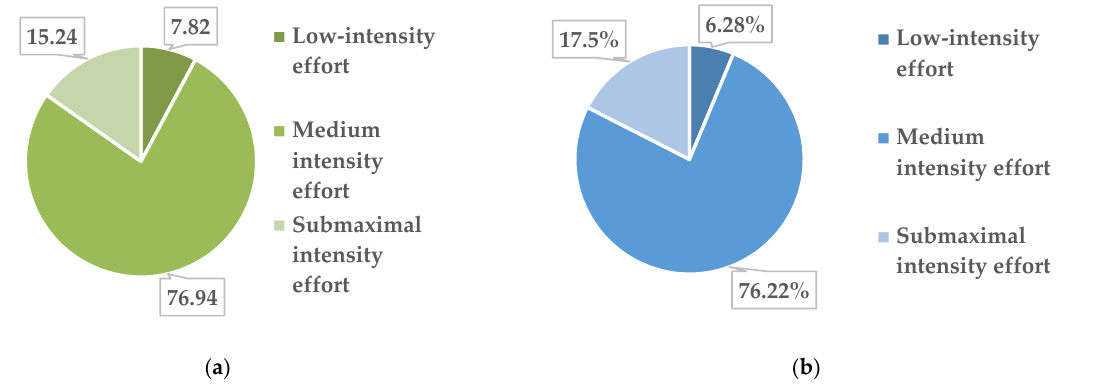
Figure 3. Distribution of physical activity by intensity of the physical effort in obese girls ( a ) and overweight girls ( b ).